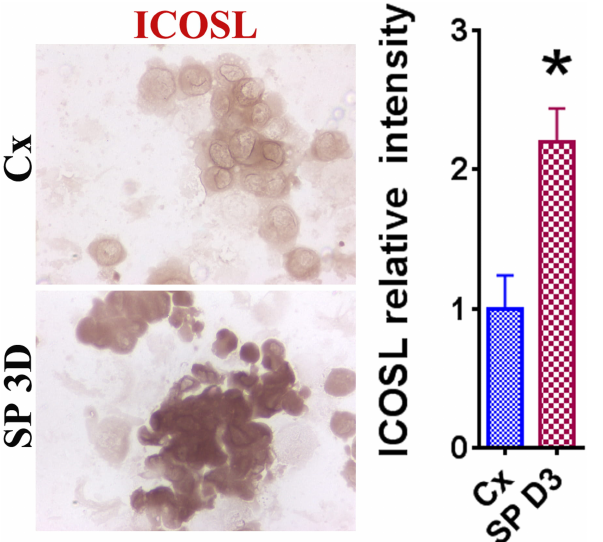
Fig. 4. The effect of SP on the expression of ICAM-2 in LNCaP cells evaluated by IHC staining. There was a decrease in stain- ing intensity observed in the group treated with SP as compared to the control group, demonstrating a decrease in the expression of ICAM-2. On 3 slides, 3–5 high power fields were selected randomly, and the relative staining intensities were assessed us- ing MetaMorph image analysis software. Shown are the original 400 × magnification IHC images. Statistically significant results are indicated by asterisk (*) ( p <